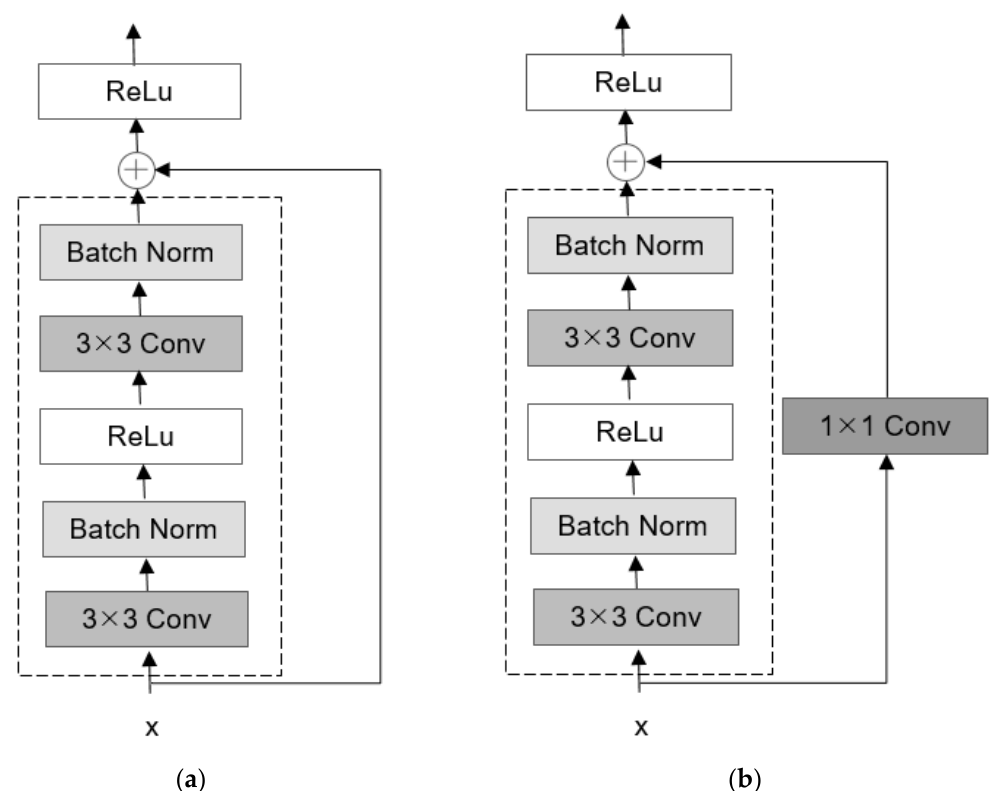
Figure 7. The residual structure without ( a ) and with ( b ) a 1 × 1 convolution layer.